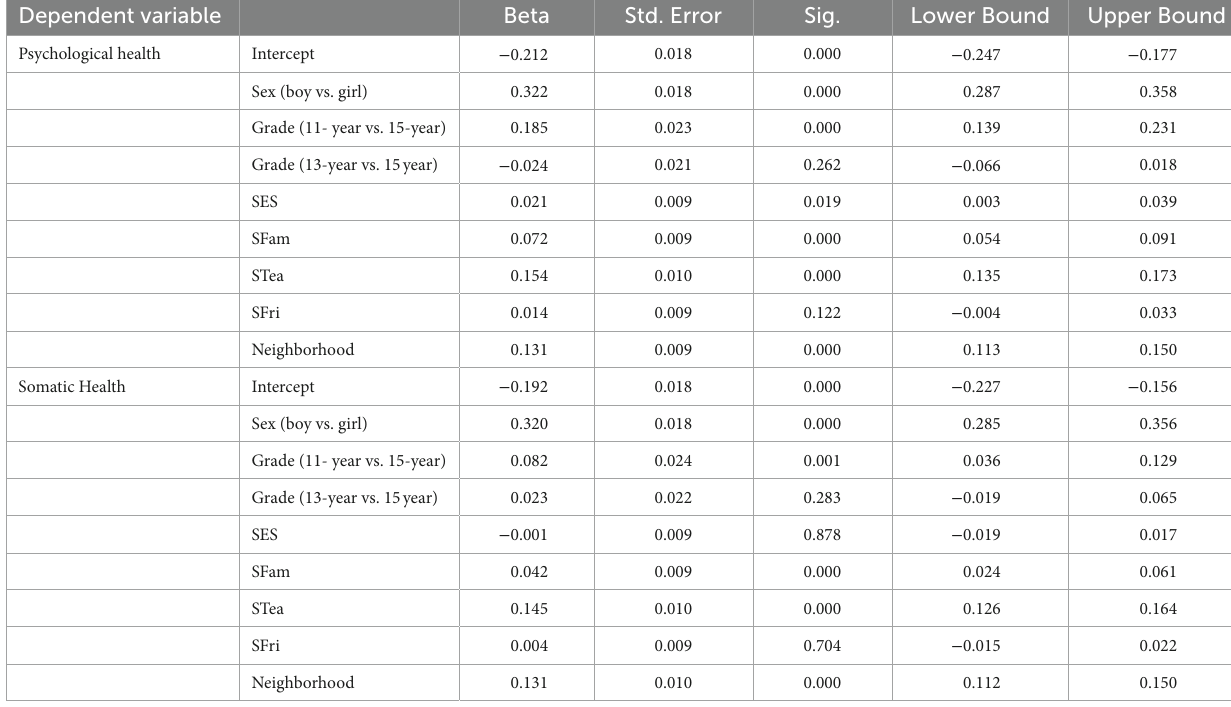
TABLE 3 The GLM model investigating the effects of three social supports on adolescents’ psychological/somatic health based on the ecological theory, excluding the mesosystem. Dependent